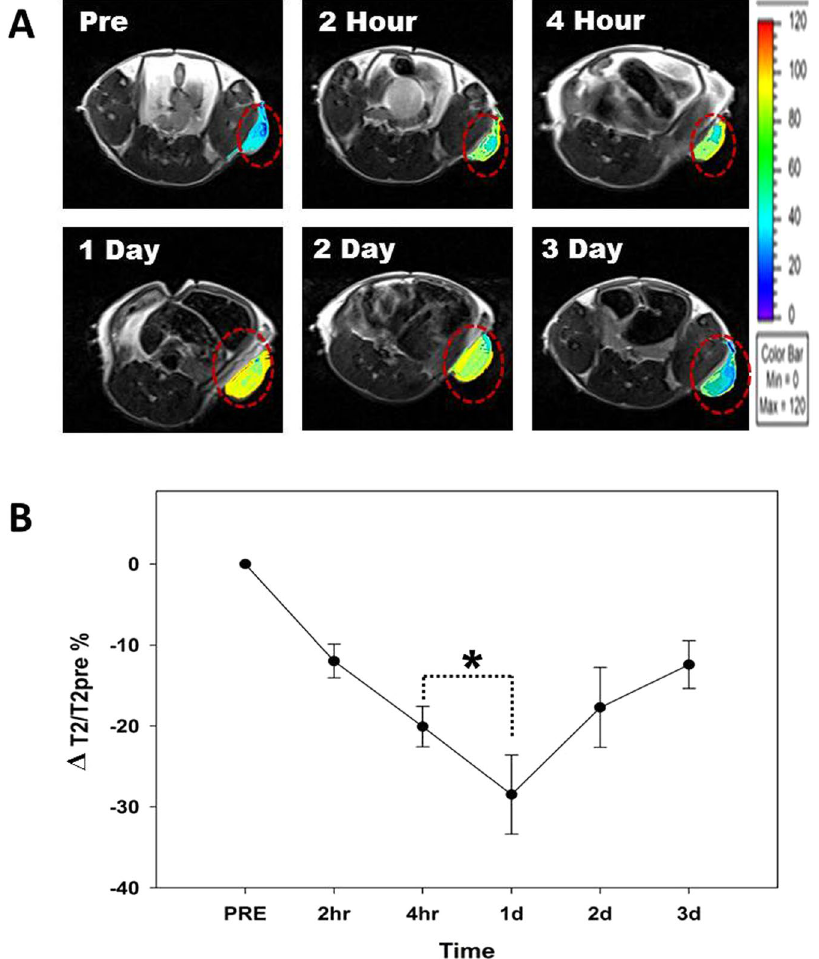
Figure 8. In vivo MRI study. ( A ) In vivo T2-weighted MRI of MHI-DSPE-SPION. ( B ) Signal change of the SCC7 tumor in T2-weighted MRI, measured at different time points (pre, 2 hrs, 4 hrs, 1d, 2d, 3d) for 10 mg[Fe]/kg. MHI-DSPE-SPION (in PBS) was injected through the tail vein. * P < 0.05 relative to the pre-injection T2 contrast (n =